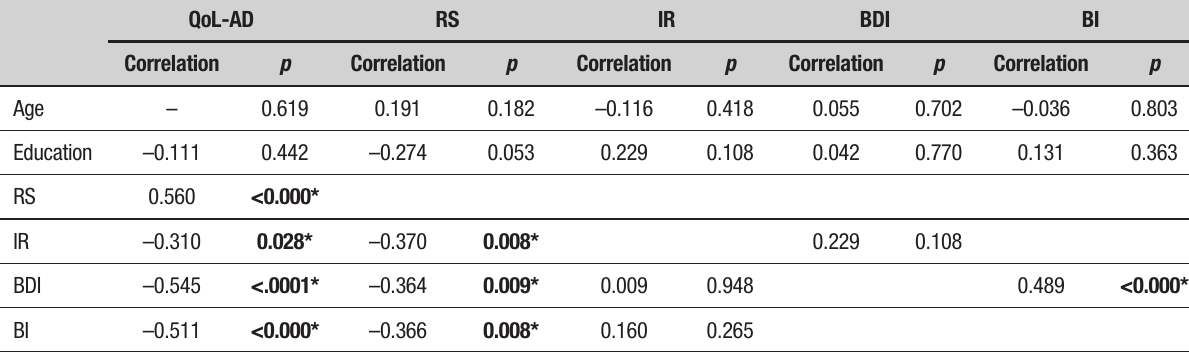
Table 2. Correlation between scores on the QoL-AD, RS, BDI, IR (PDUREL), BI, age and education of the family caregiver.